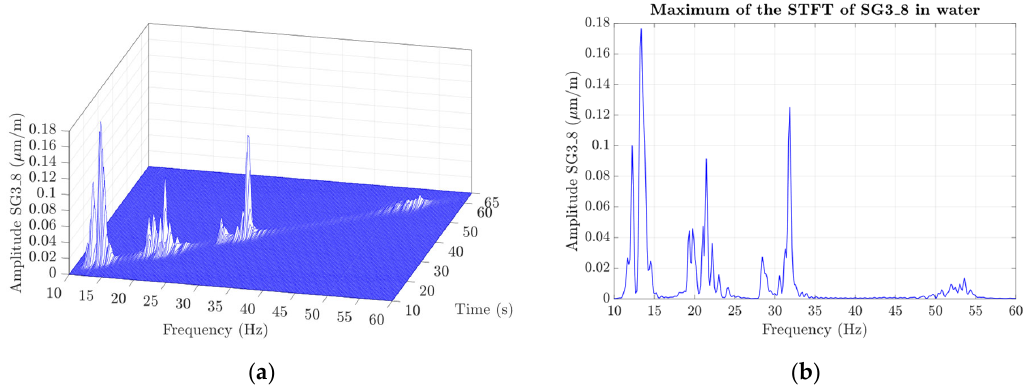
Figure 6. ( a ) Waterfall result obtained from the STFT analysis of SG3_8 when the disk was sub ‐ merged in water and rotating at 50 rpm while excited with a chirp signal ranging from 0 to 100 Hz. ( b ) Maximum spectrum of the STFT, showing the different natural frequencies in water.